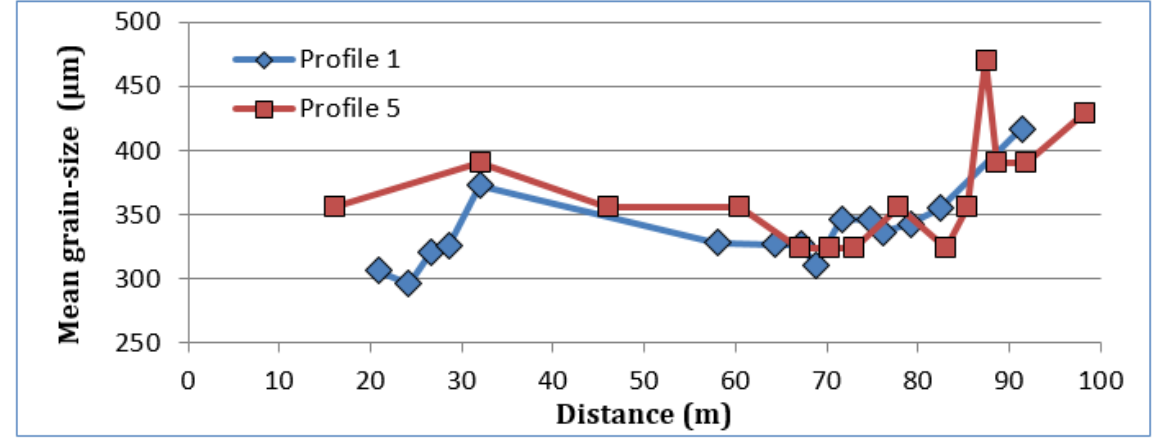
Figure 4. Evolution of mean grain size in the dune system with distance from the landside to the beach, in profile 1 (blue diamonds) and profile 5 (red squares). It is observed that the size increases from 70 m to 100 m. The larger size of the two profiles corresponds to the ridges of the embryonic and primary dunes of profiles 1 and 5, respectively.